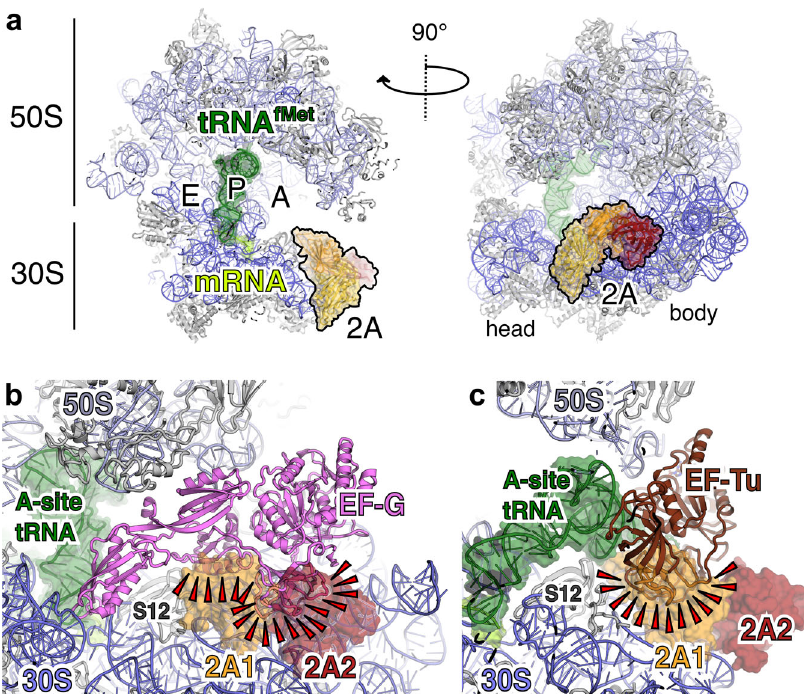
Fig. 7 2A binding may clash with translational GTPases. a Ribbon diagram of initiated 70S-mRNA-tRNA fMet -2A complex. Ribosome sites are labelled A, P and E. The initiator tRNA fMet (dark green), mRNA (light green), and 2A (orange, red, yellow) are shown in two orthogonal views. b Comparison of 70S-2A complex to 70S pre-translocation complex with EF-G (4V7D [10.2210/pdb4v7d/pdb]). 2A binding would clash (red wedges) with EF-G binding. c Comparison of 70S-2A complex to 70S complex with EF-Tu (5WE6 [10.2210/pdb5we6/pdb]). 2A binding would clash (red wedges) with EF-Tu